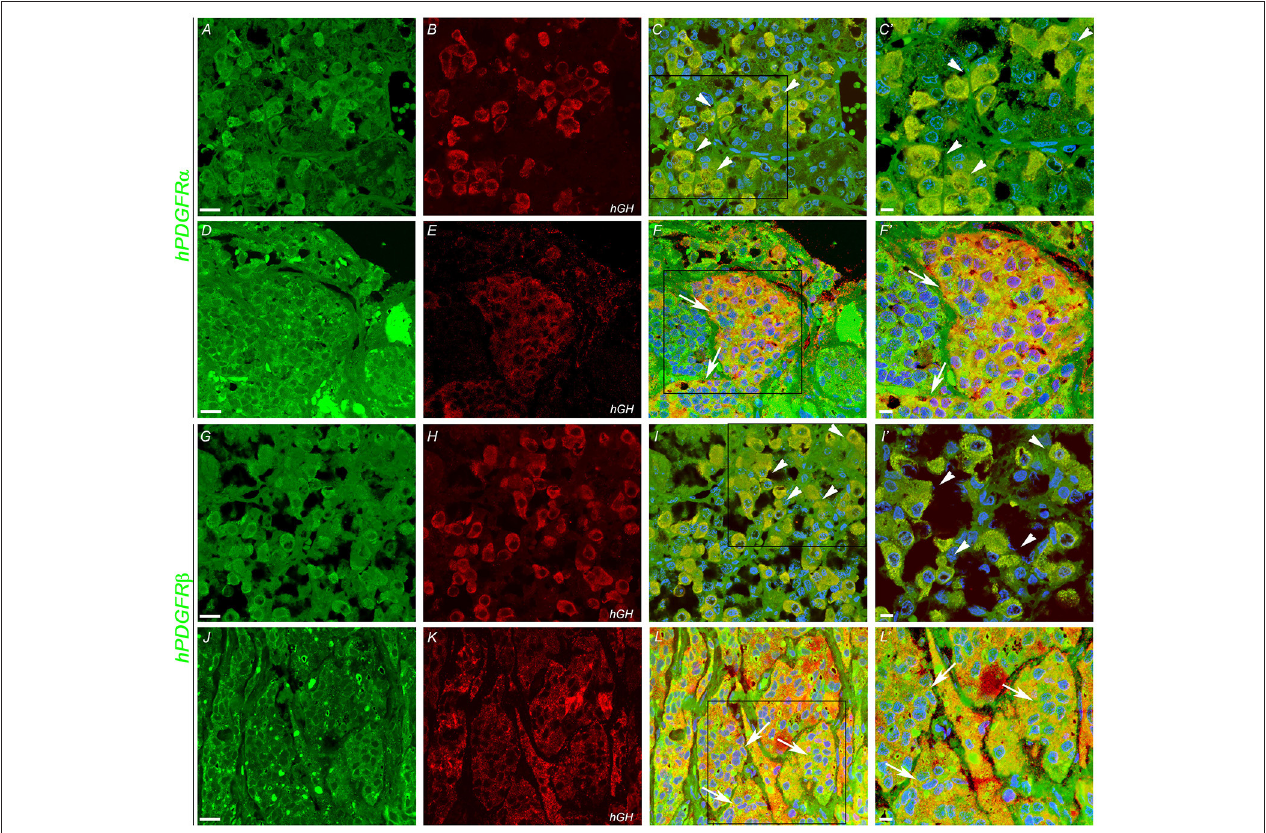
FIGURE 4 | Double immunofluoroscence showing co-expression (arrows) of PDGFR- α and PDGFR- β (green) and of hGH (red) in normal pituitary gland (A,B,G,H) and in somatotropinoma (D,E,J,K) . Overlays of the green and red channels are shown in the third column. (C ′ ,F ′ ,I ′ ,L ′ ) are the magnified views of the boxes marked in (C,F,I,L) respectively. Scale bar = 100 µ m (A–L) , 50 µ m (C ′ ,F ′ ,I ′ ,L ′ )